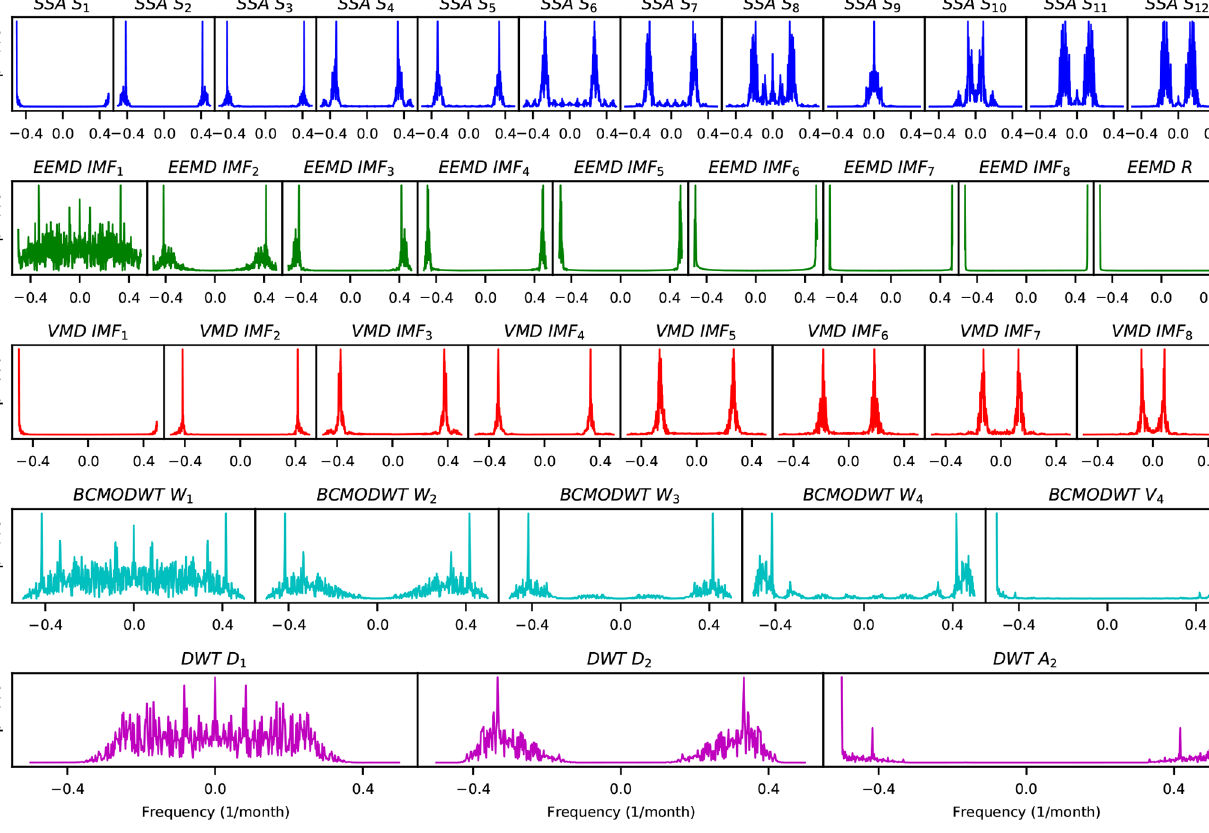
Figure 14. Frequency spectra of the signal components for the time-series data of the Huaxian station. The spectra are shown for the SSA, EEMD, VMD, BCMODWT, and DWT decomposition